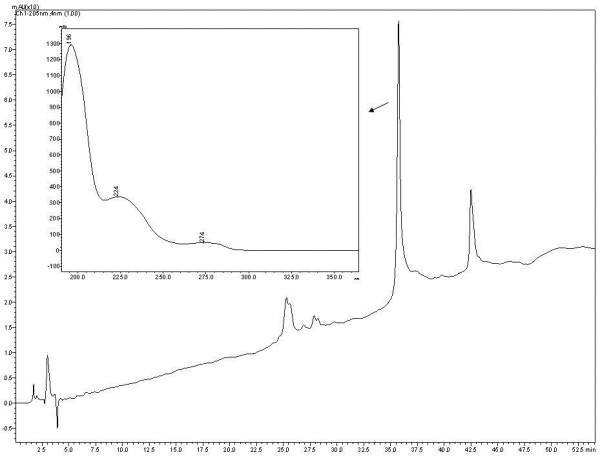
HPLC-DAD chromatogram at 205 nm of the extract from Dioscorea villosa.